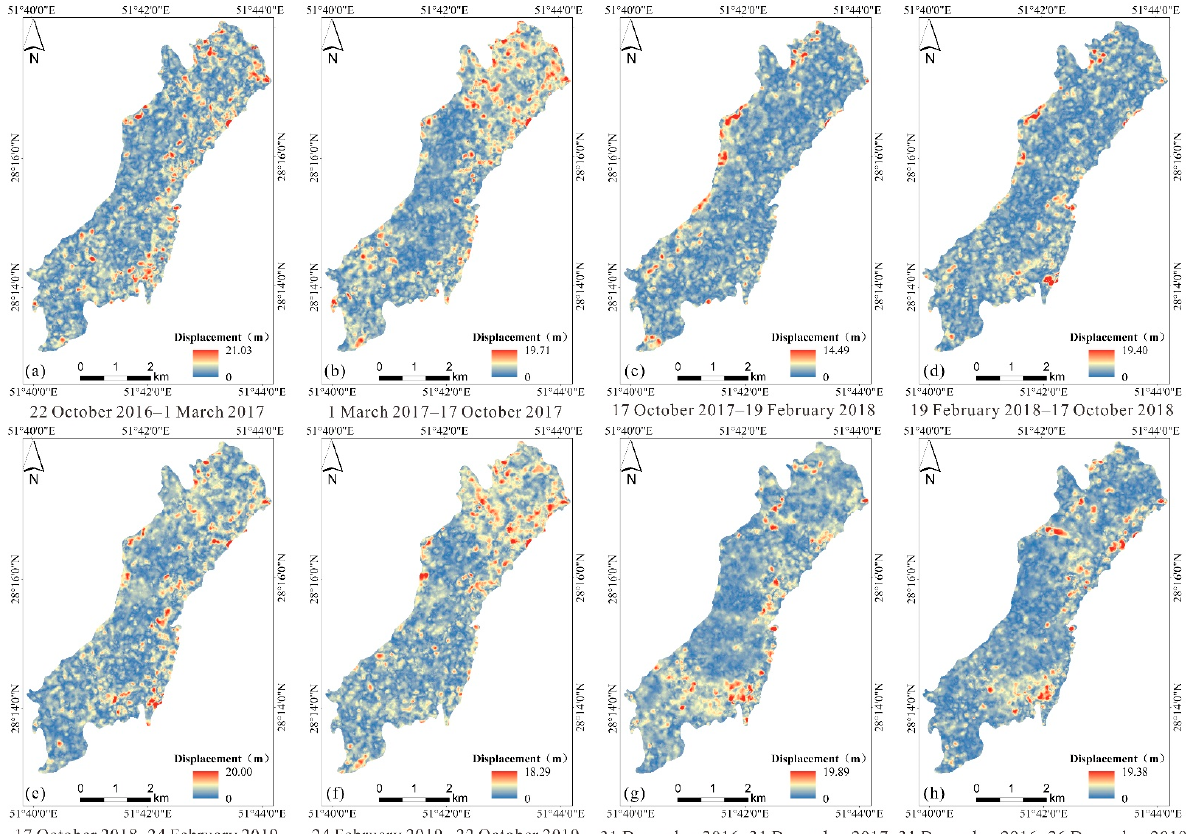
Figure 5. Surface deformation map of Kuh-e-Namak (Dashti) namakier in each Sentinel-2A/B image pair. Total displace- ments are produced as the Euclidean distance. ( a – h ) represent the surface displacement measurement of the eight correlation pairs in Table 4. Table 4. Displacement and deformation velocity of Kuh-e-Namak (Dashti) namakier in each Senti- nel-2A/B image pair and accumulated precipitation and average temperature during each image pair acquisition time interval.